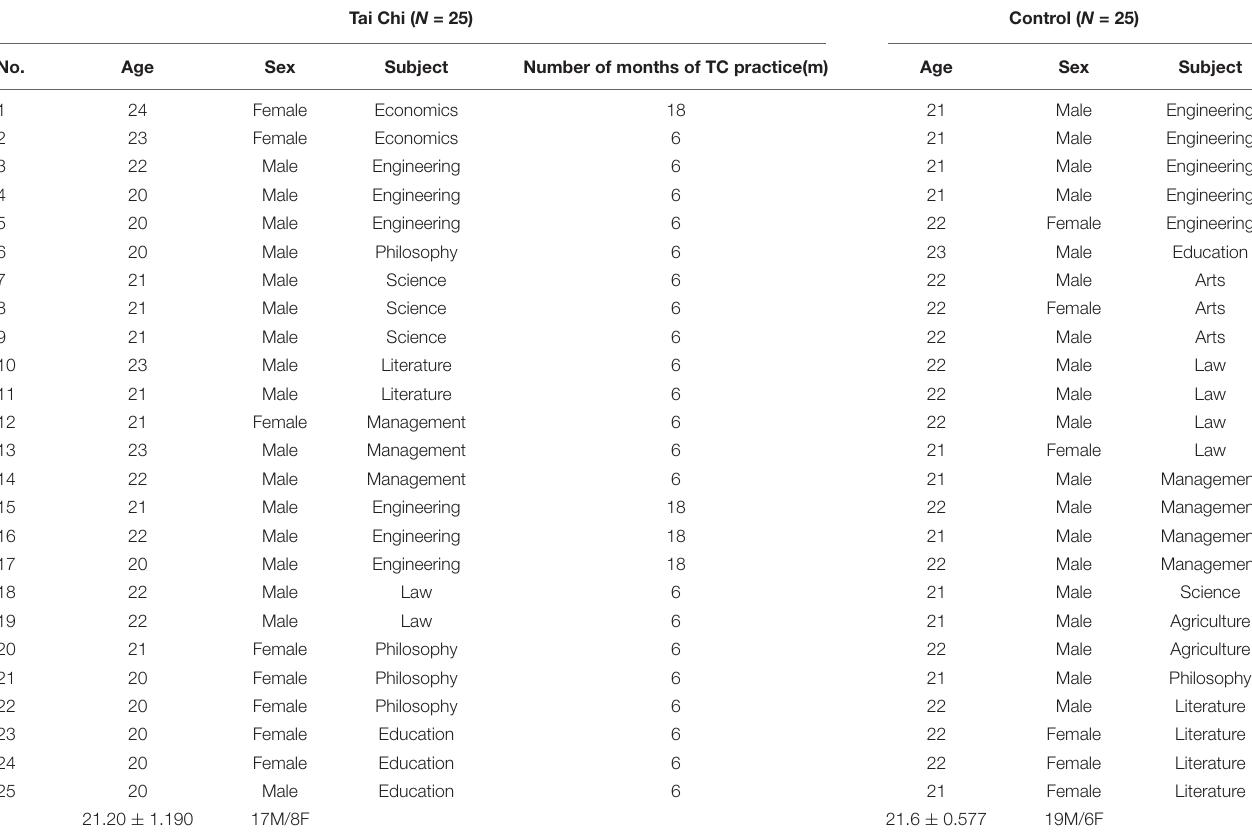
TABLE 1 | Demographic